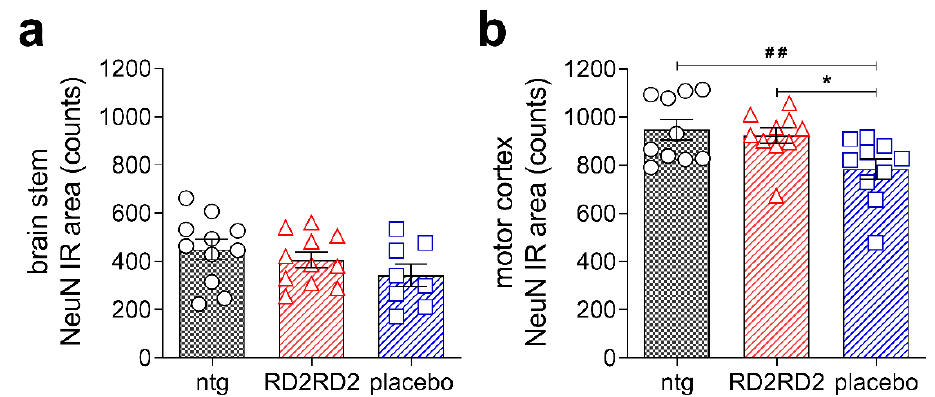
Figure 4. Treatment with RD2RD2 rescued significantly neurons in the motor cortex of SOD1*G93A mice. Analysis of neurons in the brain stem ( a ) and motor cortex ( b ) revealed a significant loss in placebo-treated SOD1*G93A mice, while the count of neurons in RD2RD2-treated mice was similar to the count of non-transgenic mice. Data is presented as mean ± SEM. Statistical calculations were conducted by one-way ANOVA with Fisher’s LSD post hoc analysis, ntg n = 11, RD2RD2 n = 11, placebo n = 8 (brain stem) and ntg n = 10, RD2RD2 n = 10, placebo n = 10 (motor cortex). Lozenges ( # ) and asterisks (*) indicate a significance between treatment groups (ntg vs. RD2RD2 or ntg vs. placebo: ## p = 0.01 and RD2RD2 vs. placebo: * p = 0.05). IR: immunoreactivity. Circles: placebo-treated ntg; triangles: RD2RD2-treated SOD1*G93A mice and squares: placebo-treated SOD1*G93A mice. Table 1. Evaluation of immunolabelling in brain and lumbar spinal cord of SOD1*G93A mice re- vealed a decrease of gliosis after treatment with RD2RD2. Data is presented as mean ± SEM. Statis- tical calculations were conducted by one- way ANOVA with Fisher’s LSD post hoc analysis. Loz- enges ( # ) and asterisks (*) indicate a significance between treatment groups (ntg vs. RD2RD2 or ntg vs. placebo: # p = 0.05, ## p = 0.01, ### p < 0.001 and RD2RD2 vs. placebo: * p = 0.05, *** p < 0.001). Statistic (one-way ANOVA IR 1 Area ntg RD2RD2 placebo Analysis of Variance)